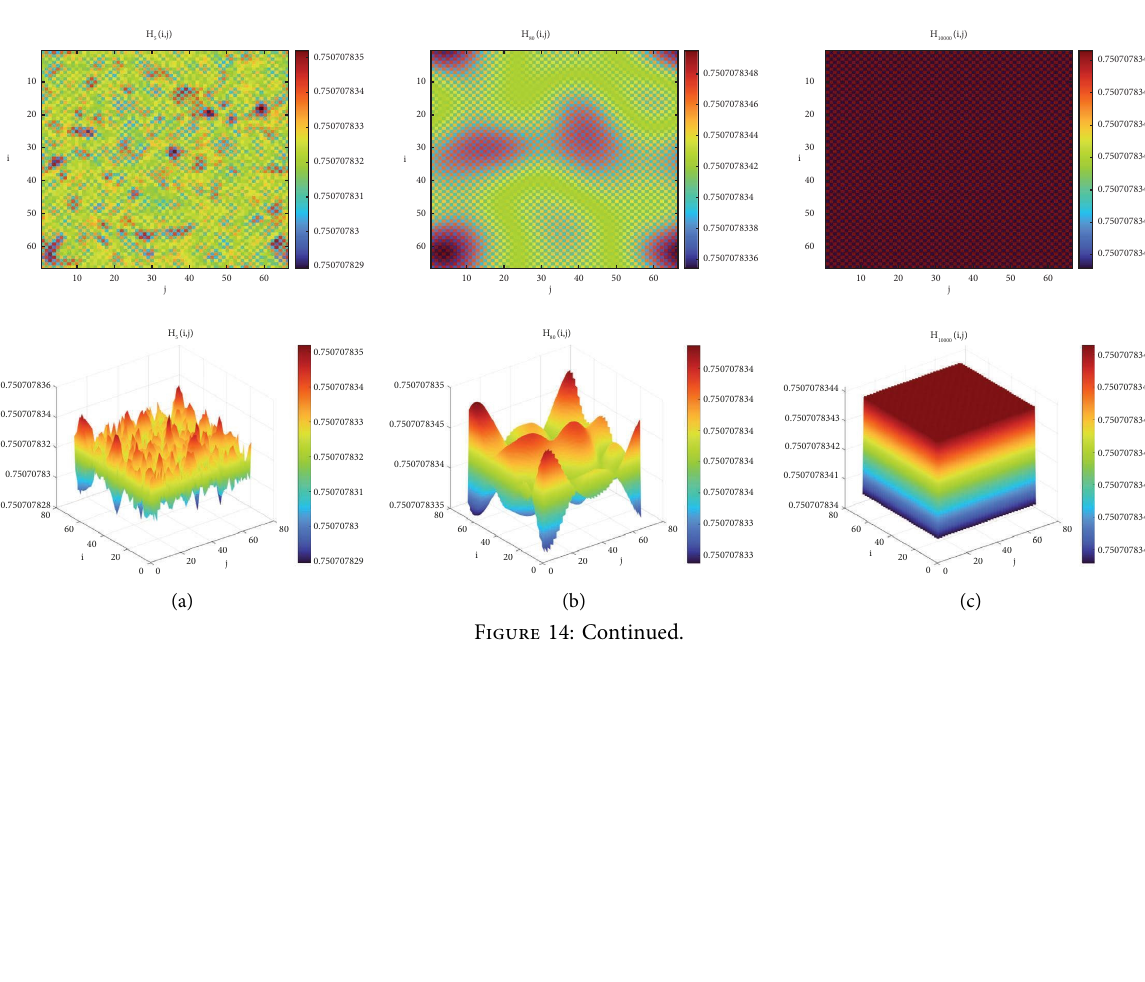
Figure 13: R � 2 , k � 1, c � 0 . 8, σ ∗ � 0 . 278655, d the case of Corollary 3(1), there exist a homogeneous stationary, parasite and host populations are maintained in a relatively stable state in two-dimensional space.